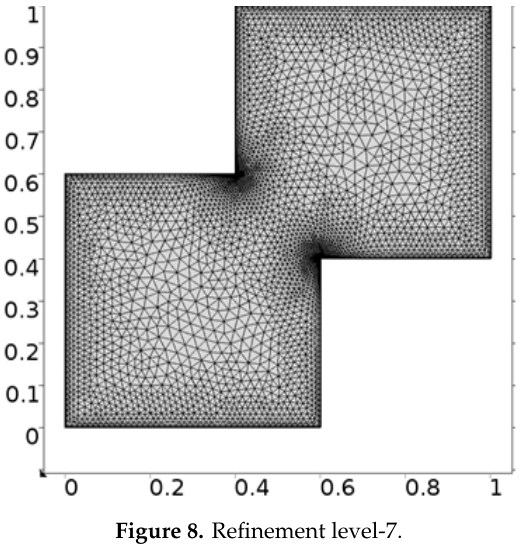
Figure 8. Refinement level-7.